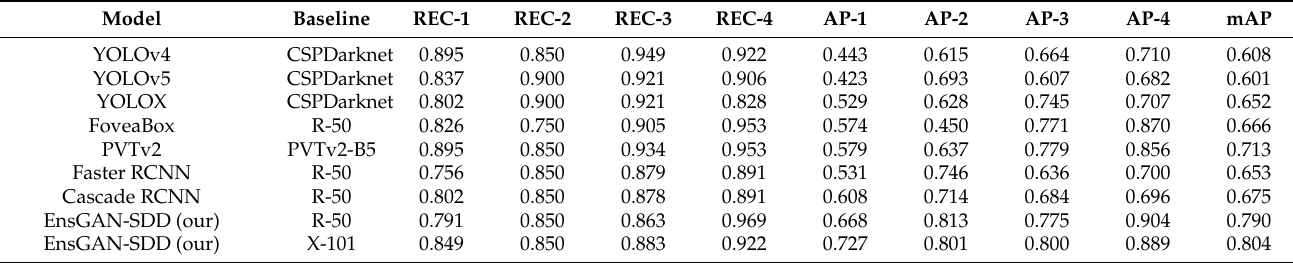
Table 4. Comparison results of the proposed EnsGAN-SDD with the state-of-the-art object detection